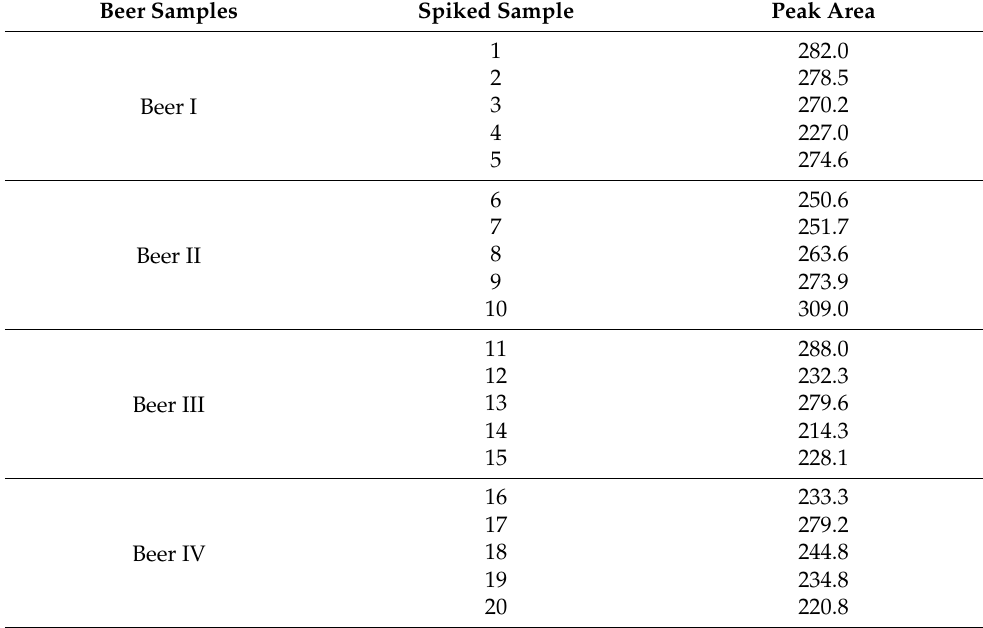
Table 1. Peak area results of beer samples (gluten < LOD) spiked with 0.5 mg/kg PTW-Cubus, obtained by the strip reader. Beer Samples Spiked Sample Peak